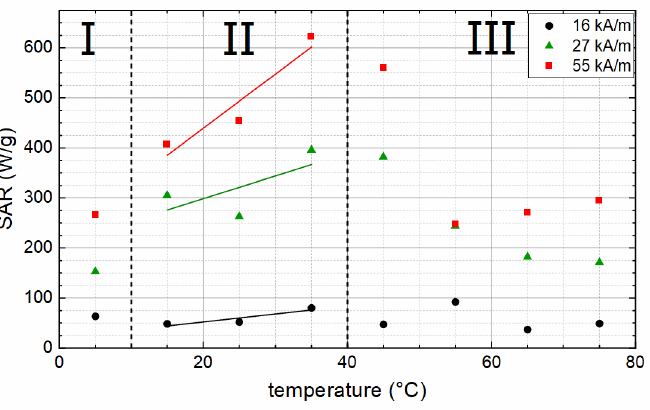
Figure 7. SAR as function of the particle synthesis temperature, measured at 16, 27, and 55 kA/m, showing three distinct regions (I–III) with different magnetic behavior dependent on particle preparation temperature, as outlined in the text. Lines serve as a guide to the eye only.